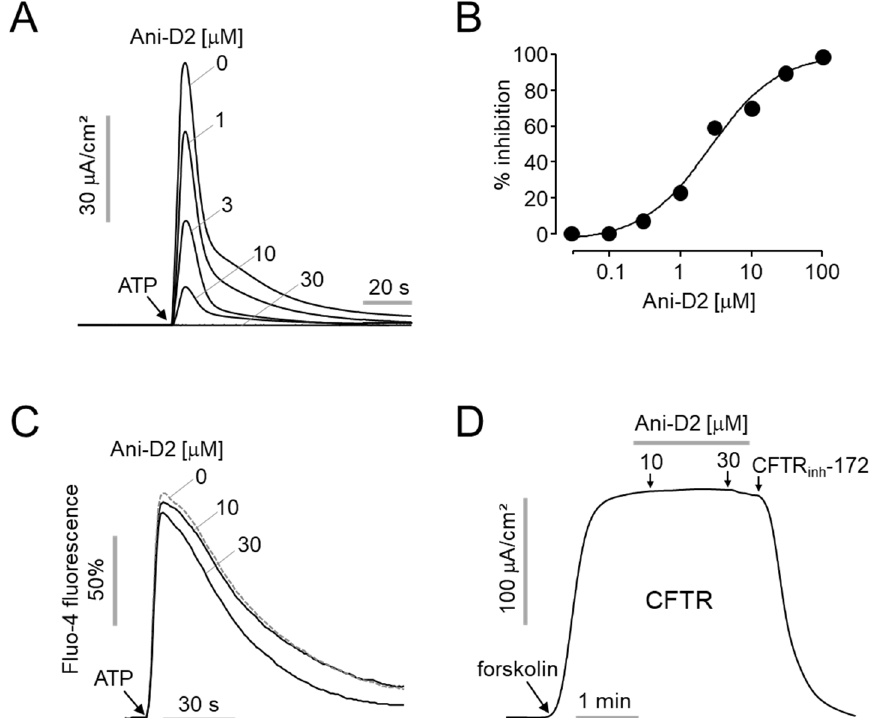
Figure 4. Characterization of Ani-D2. ( A ) Effect of Ani-D2 on apical membrane current was observed in FRT cells expressing ANO1. Ani-D2 was applied at the indicated concentrations 20 min prior to ANO1 activation by 100 μ M ATP. ( B ) Summary of dose–responses (mean ± S.E., n = 3–4). ( C ) Effect of Ani-D2 on intracellular calcium concentration was measured by Fluo-4 / NW in FRT cells. The cells were pretreated with 0, 10, 30 μ M of Ani-D2 for 20 min prior to the treatment of 100 μ M ATP. ( D ) Effect of Ani-D2 on CFTR chloride channel activity was observed in FRT cells expressing human CFTR. CFTR chloride currents were activated by 10 μ M forskolin and inhibited by 10 μ M CFTR inh - 172.